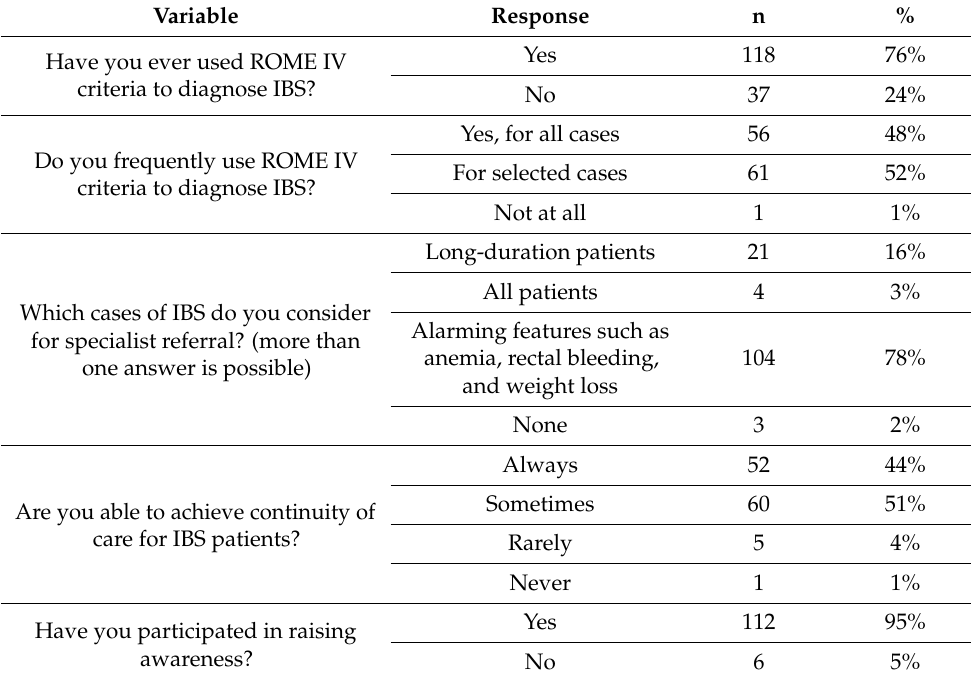
Table 5. Practice of ROME IV criteria among primary care physicians for the diagnosis of